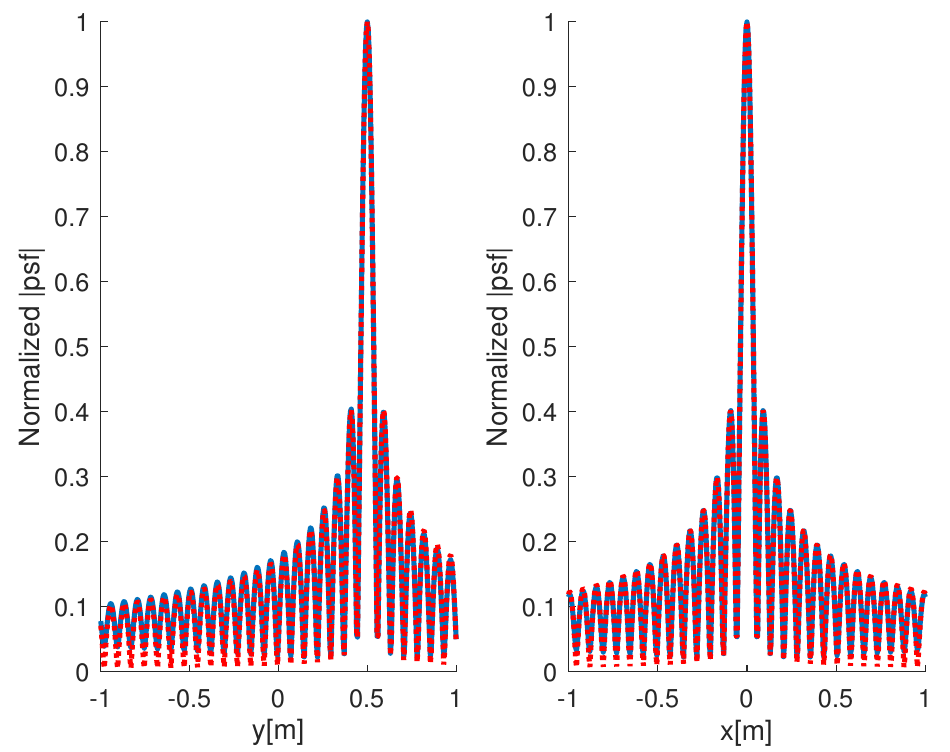
Figure 3. Comparison between the normalized point-spread function amplitude (blue line) and the one returned by (23) (red dotted line). The left panel refers to the cut along the y -axis whereas the right one to the cut along the x -axis. The frequency is 1 GHz while the observation curve is an ellipse with axes 2 m and 2.5